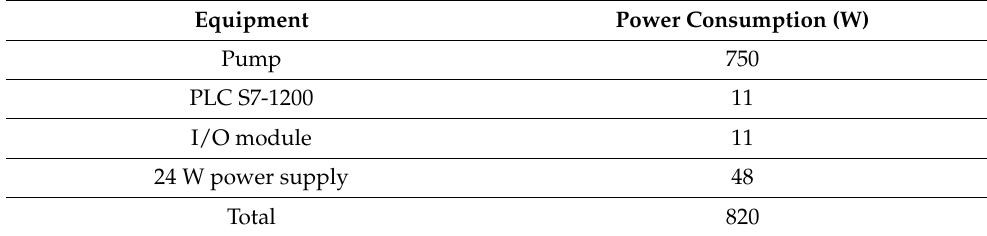
Table 2. Energy consumption of the smart irrigation system.